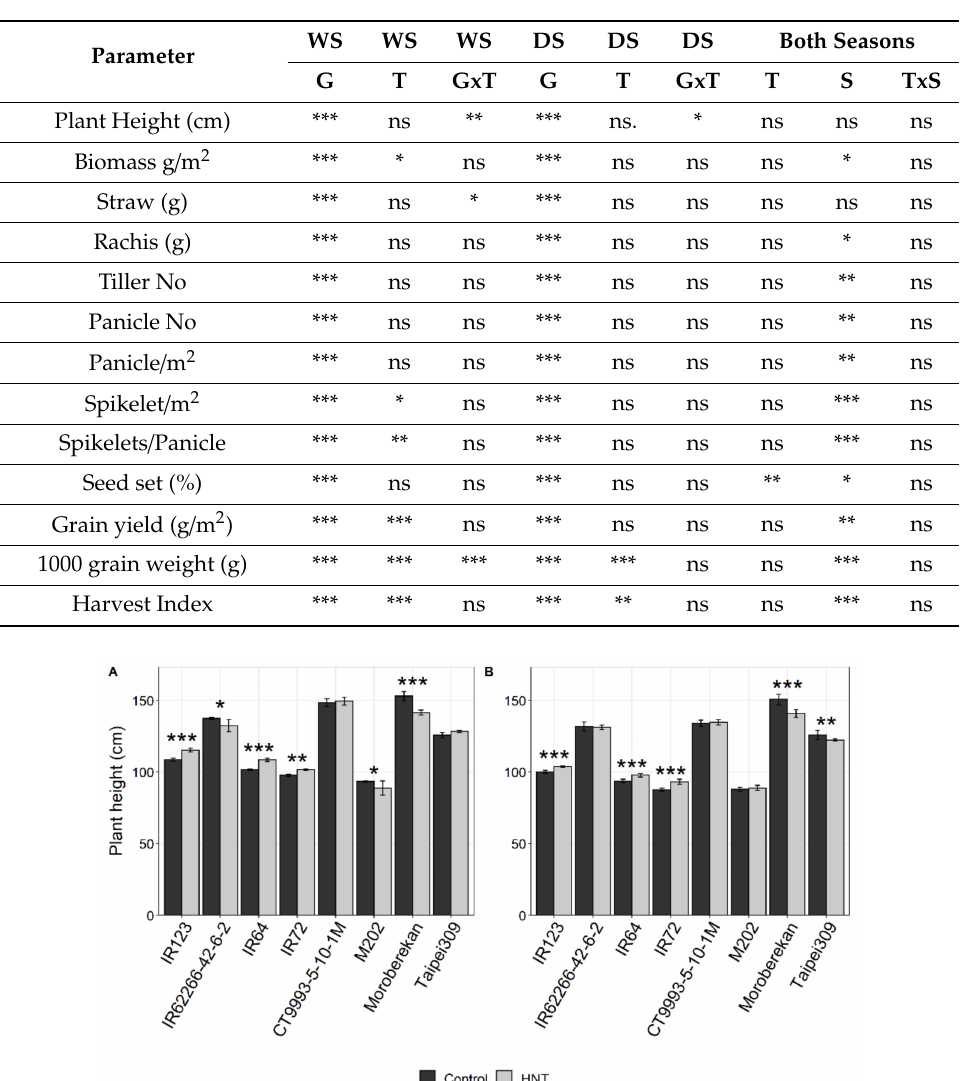
Table 2. Analysis of variance (ANOVA) on selected agronomic parameters. Sixty plants for the DS and 24 plants for the WS were considered for plant height, tiller number and panicle number. For the remaining parameters, two replicates pooled from twelve plants each were considered for the WS and five replicates pooled from twelve plants each were considered for the DS. Spikelets / panicle represents the number of spikelets per panicle. The seed set was calculated as follows: seed set (%) = filled grains / (filled + half-filled + unfilled grains) × 100. Harvest index was calculated as percentage of dry weight of filled grains relative to total above-ground biomass. The significance of the influence of genotype (G), HNT-treatment (T), season (S) or the interaction between two influences (GxT or TxS) on di ff erences between HNT and control conditions across all eight cultivars is indicated by asterisks: 0.001 < ***; 0.001 > ** < 0.01; 0.01 > * < 0.05. ns—not significant. Original data for plant height, tiller number, panicle number and all yield components for the WS (2011) and the DS (2014) are available in